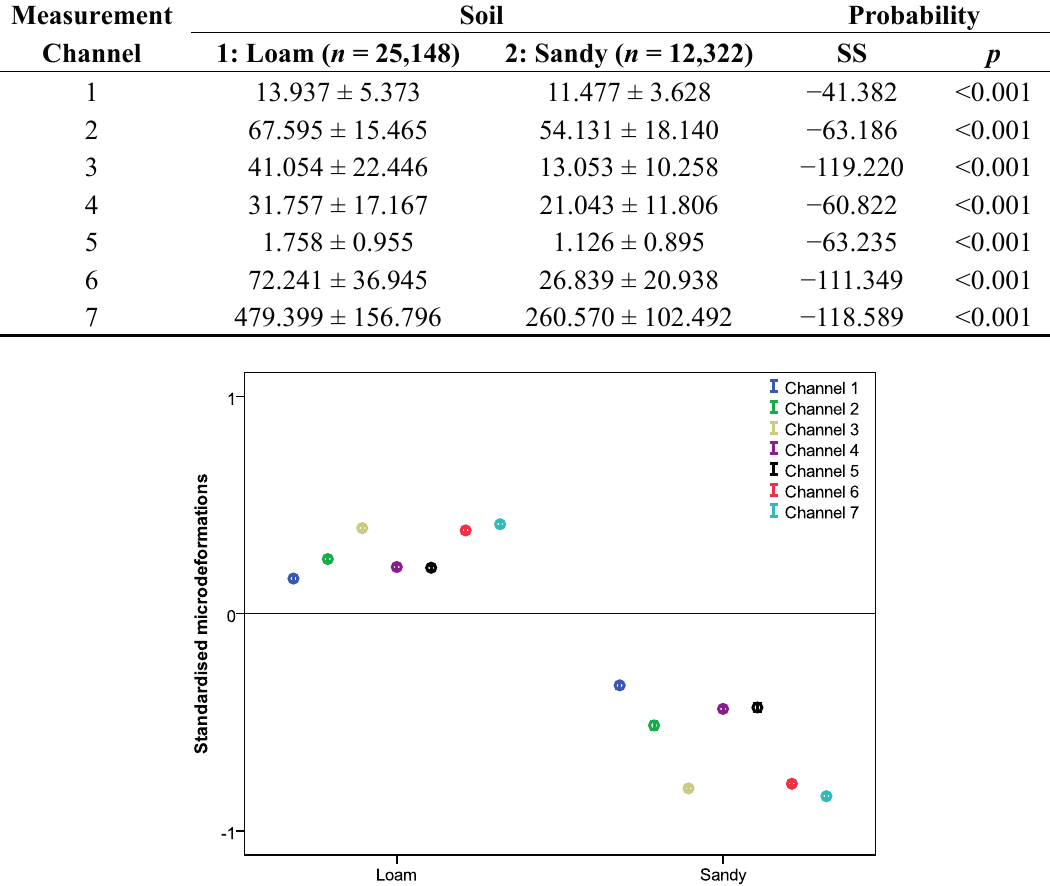
Table 5. Means and standard deviations of micro-strains ( με ) measured by gauges depending on the soil tested. Mean differences tested with the Mann-Whitney U-test. SS: Standardised Statistic.